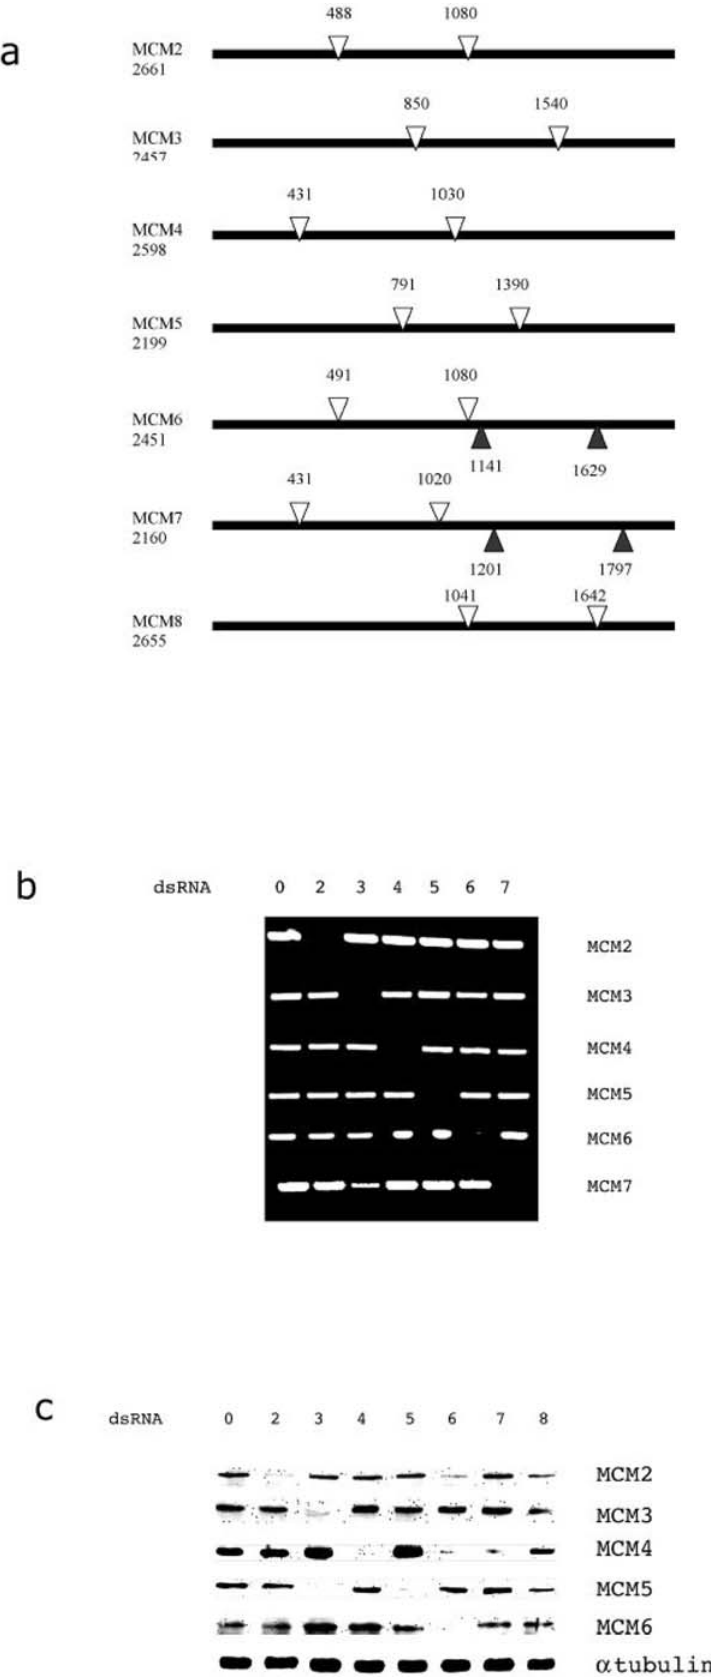
Figure 2. a. Schematic detailing the regions of each MCM targeted for dsRNA. Base positions are quoted relative to the start AUG. Shaded arrows designate the 2 nd dsRNA made from MCM6/7. b. Agarose gel of RT-PCR products showing the effects of RNAi depletion of individual MCMs on MCM mRNA expression levels. Horizontal numbers designate the MCM targeted by RNAi. Vertical numbers show the RT PCR target. The data presented is one complete representative data set from multiple repetitions. c. Western blot to show the effect of RNAi depletion of individual MCMs on MCM protein expression levels in total cell extracts. Horizontal numbers designate the MCM targeted by RNAi. Vertical numbers show the antibody used for western blotting. Tubulin expression is included as a loading control. The data presented is one complete representative data set from multiple repetitions.